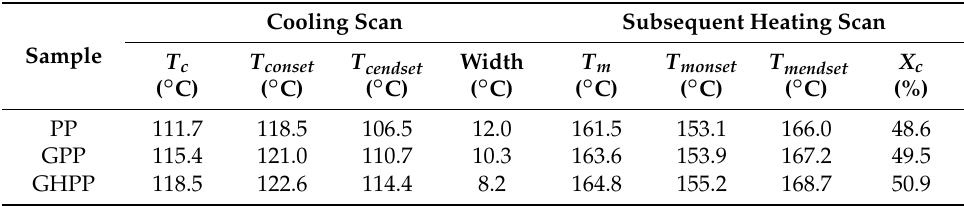
Figure 3. ( a ) Differential scanning calorimetry (DSC) cooling curves and ( b ) subsequent heating curves of the samples. The cooling and subsequent heating rates were 10 °C/min. Table 2. Crystallization and melting parameters of polypropylene (PP), iPP/GO (GPP), and iPP/GO-H202 (GHPP).